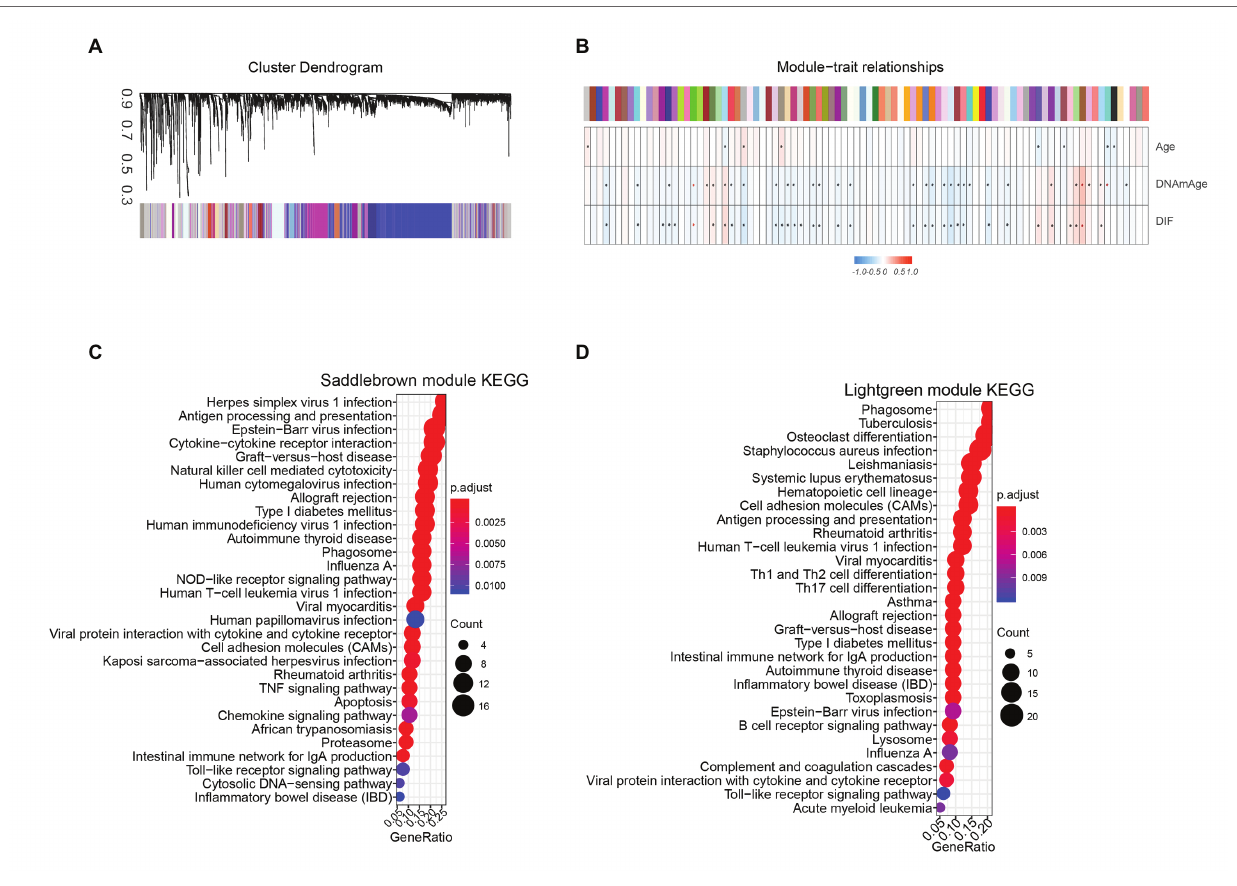
FIGURE 6 | Epigenetic age associated gene modules in TCGA STAD cohort. (A) Using weighted gene co-expression network analysis, we identified 90 co-expressed gene modules in TCGA STAD cohort. Average linkage hierarchical clustering dendogram of the genes. Input was the topological overlap-based dissimilarity. Modules, which are designated by color code, are the branches of the clustering tree. (B) Eight gene modules were positively correlated with DNAm age in STAD patients. Twenty-one gene modules were negatively correlated with DNAm age in STAD patients. Color represents independent gene module, Correlation of module eigengenes to clinical and pathological traits. Each column corresponds to a module eigengene, and the row represents the DNAmage variables. *represent p < 0.05, DIF, DNAmage shift value. Genes in top two DNAm-age-associated gene modules, including Saddlebrown (C) and Lightgreen (D) modules, were significantly enriched in immune-related pathways. STAD, stomach adenocarcinoma; TCGA, The Cancer Genome